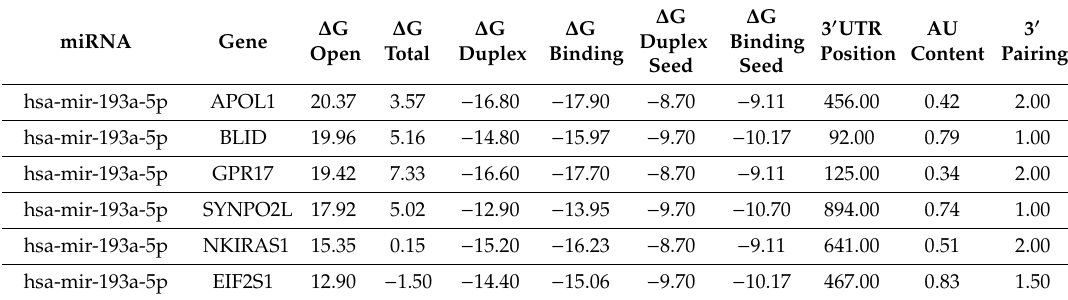
Table 3. Comparison of miR193a-5p